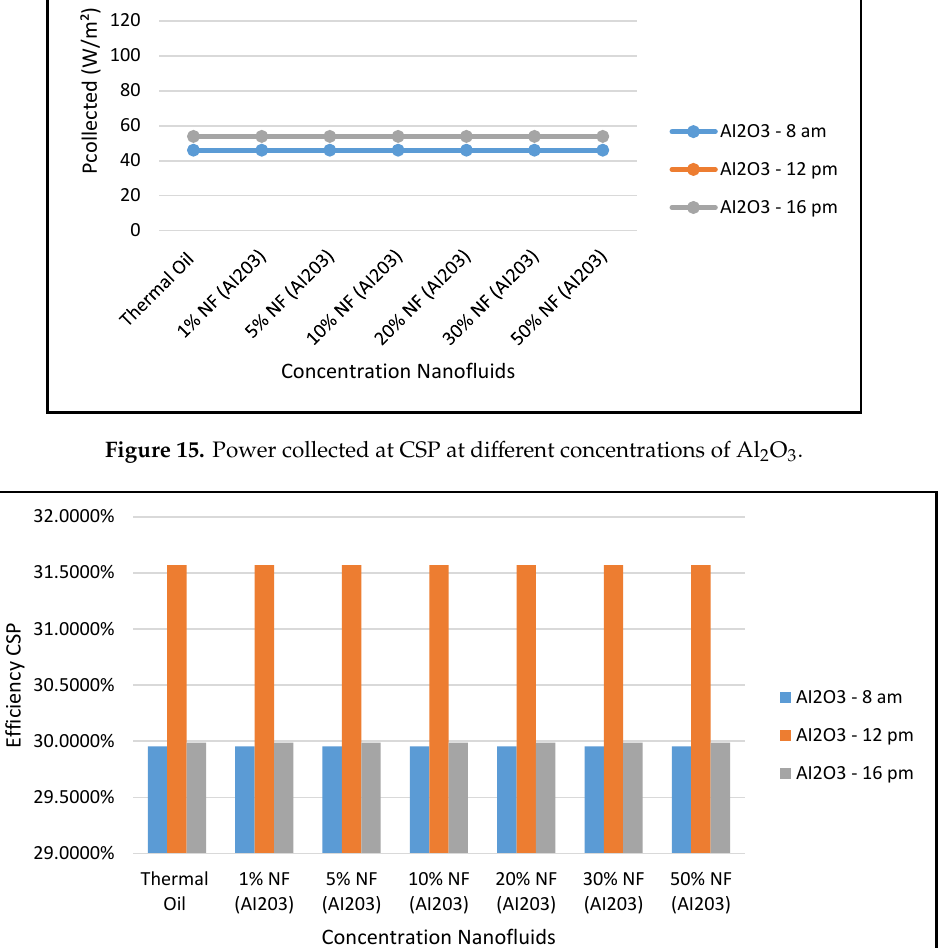
ffi ciencies of the CSP collector at di ff erent concentrations of Al Figure 16. Efficiencies of the CSP collector at different concentrations of Al 2 O 3 . Figure 16. E